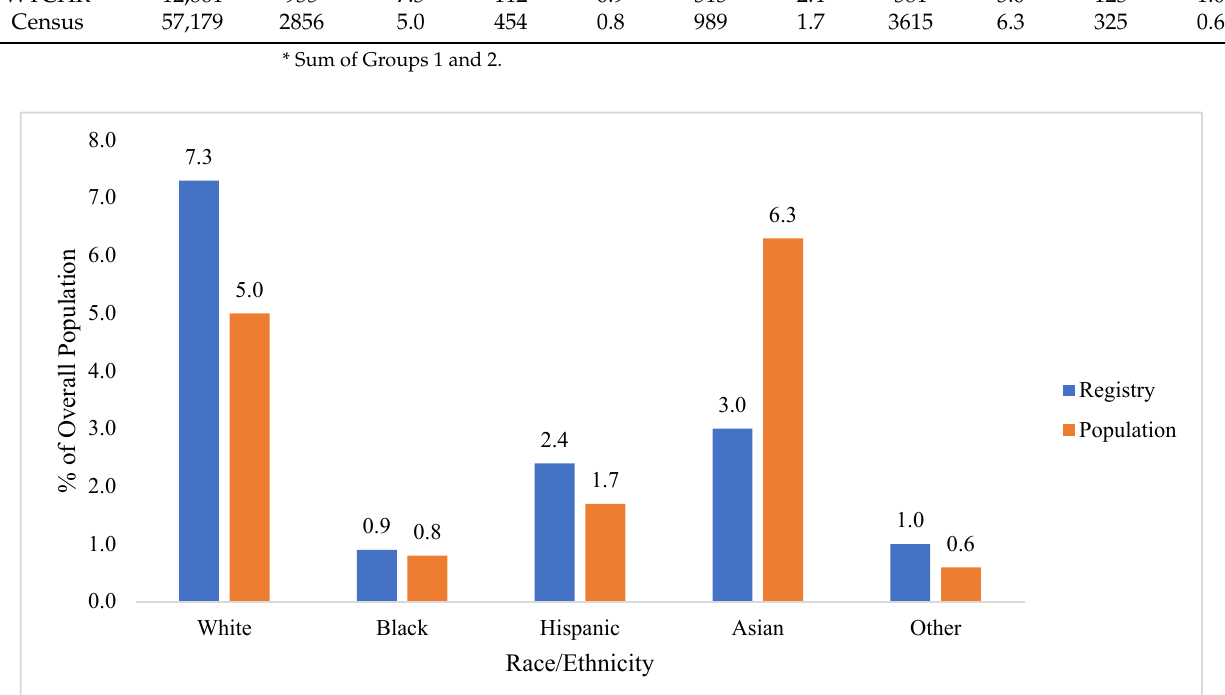
Figure 3. Comparison of proportions by Race/Ethnic groups of WTCHR (Registry) resident children to population south of Canal Street in Lower Manhattan in 2000.